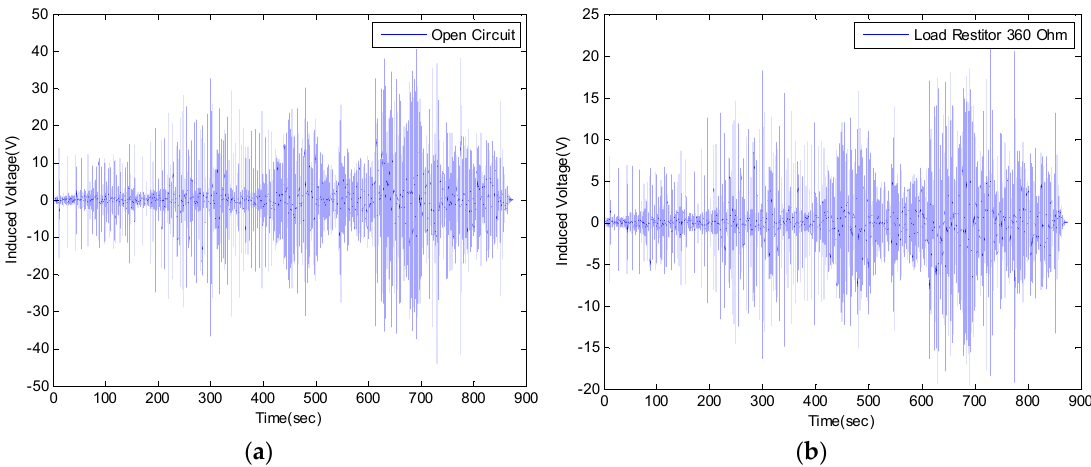
Figure 6. The generated voltage of the VEH device for the high-speed train for the lower coil before the spring damage on the high-speed train test about 900 sec: ( a ) the induced voltage (V); open-circuit peak to peak voltage and ( b ) the induced voltage (V) with a 360 Ω load resistance—the peak to peak voltage.